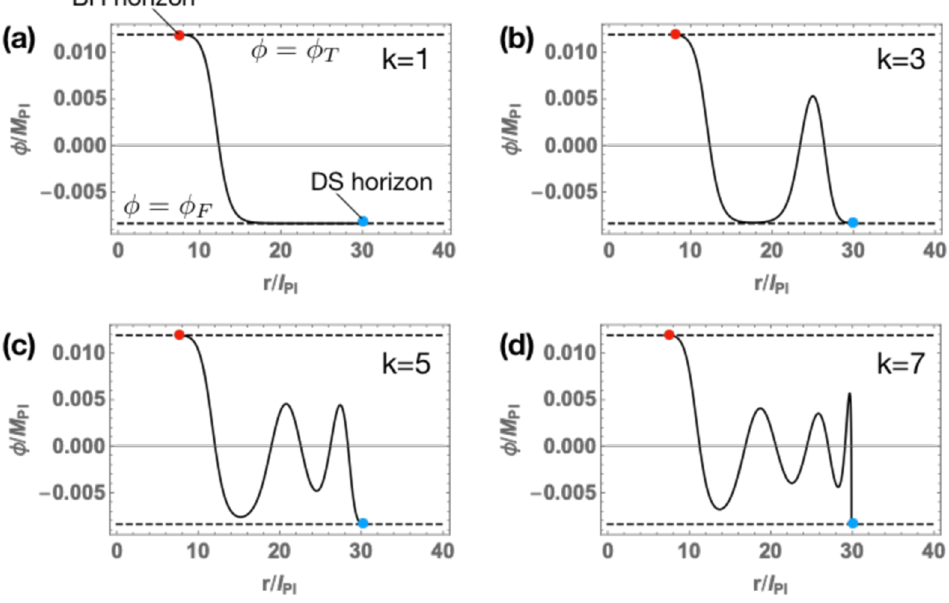
Figure 4 . Bounce solutions for k = 1 ; 3 ; 5 ; and 7 with (cid:12) = 250 and ( G 3 V top ) 1 = 2 (cid:22) (cid:0) = 0 : 04. Red and Blue points denote the BH and cosmological horizons,